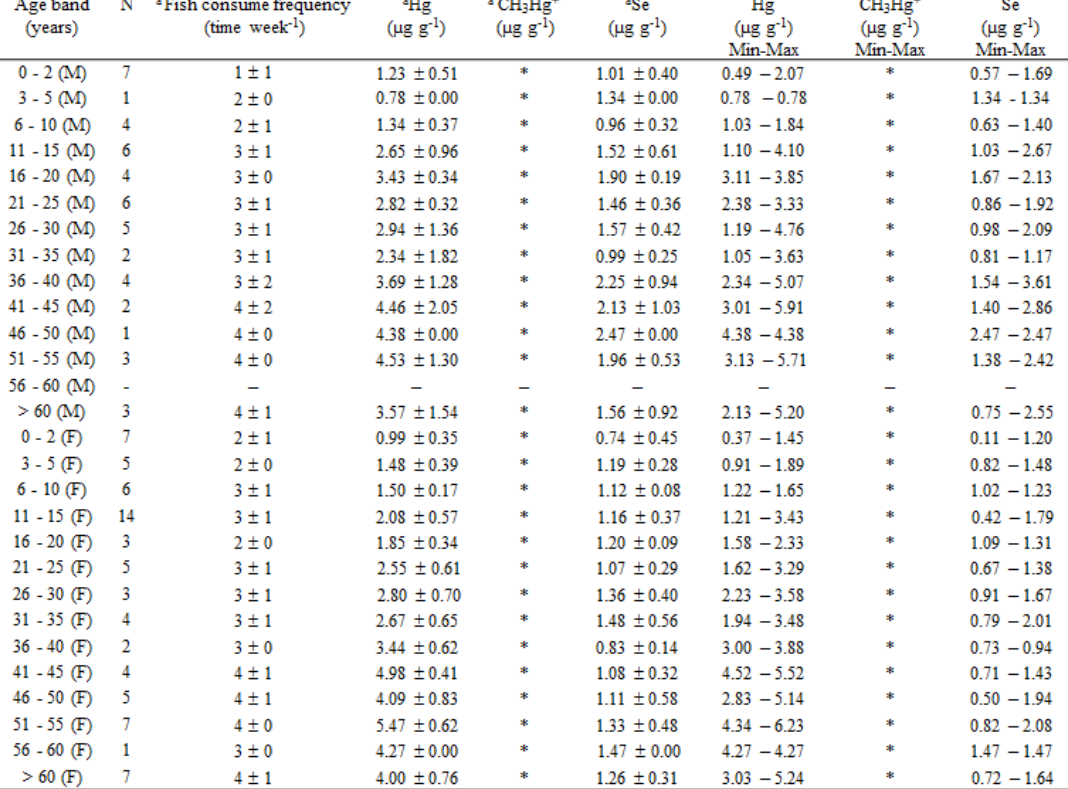
Table 2: Results of Hg, CH 3 Hg + , Se concentration in hair samples and fish consume frequency, for age band; of people residents in Juruti municipality - Tabatinga community (area without mining impact), belonging to the Tapajós basin, Pará state (Amazon, Brazil).